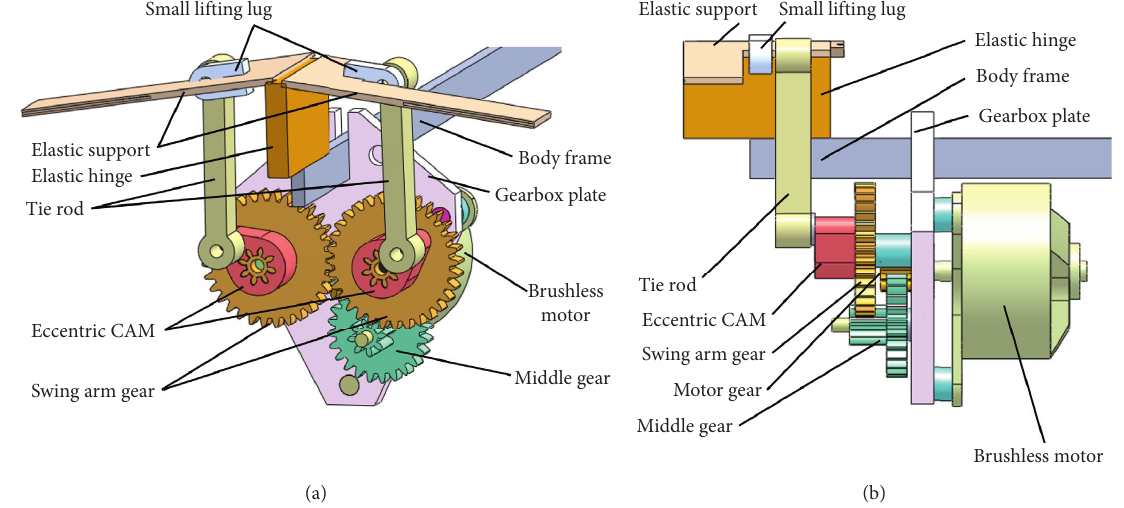
Figure 7: Gearbox structure composition. (a) Gearbox isometric view. (b) Gearbox side view.